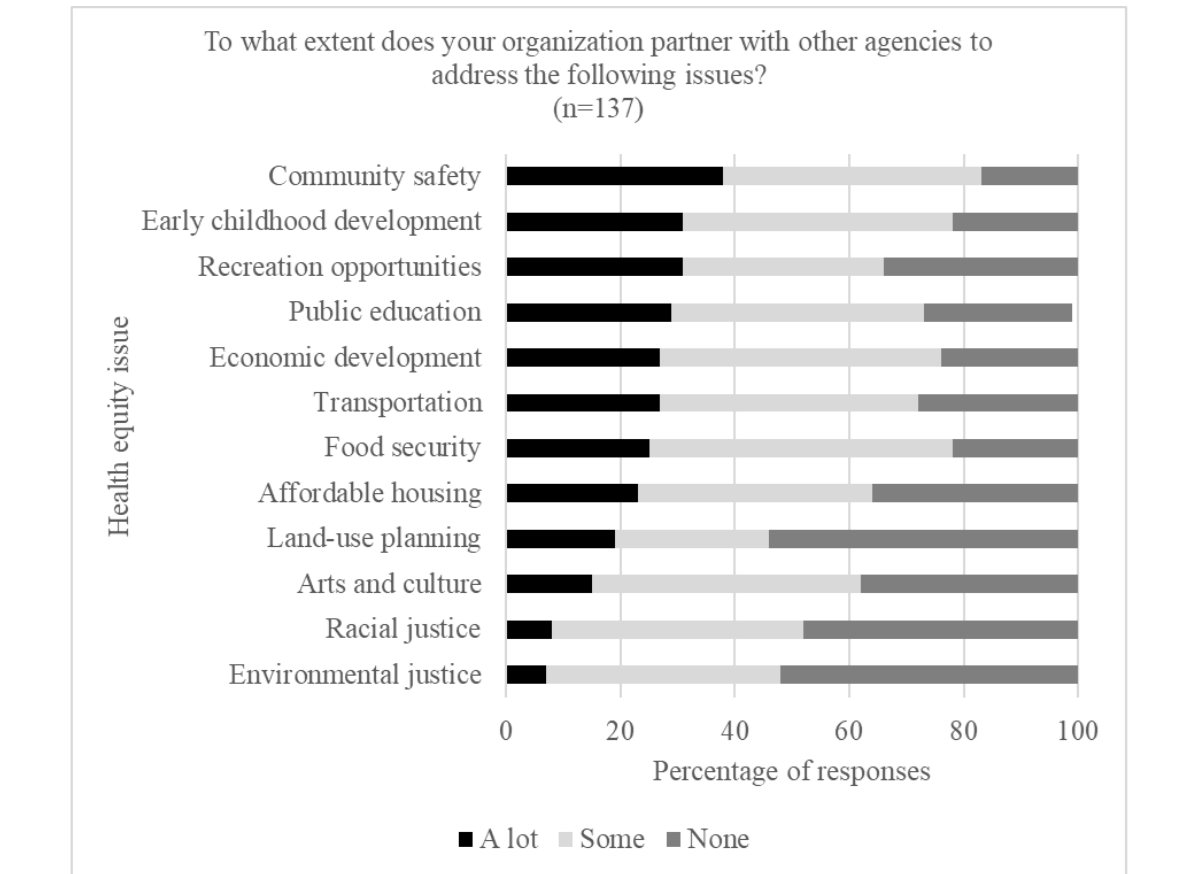
Figure 4. Extent of cross-sectoral collaborations on health equity